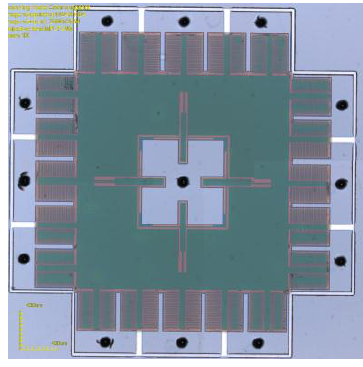
Figure 12. Picture of an accelerometer.